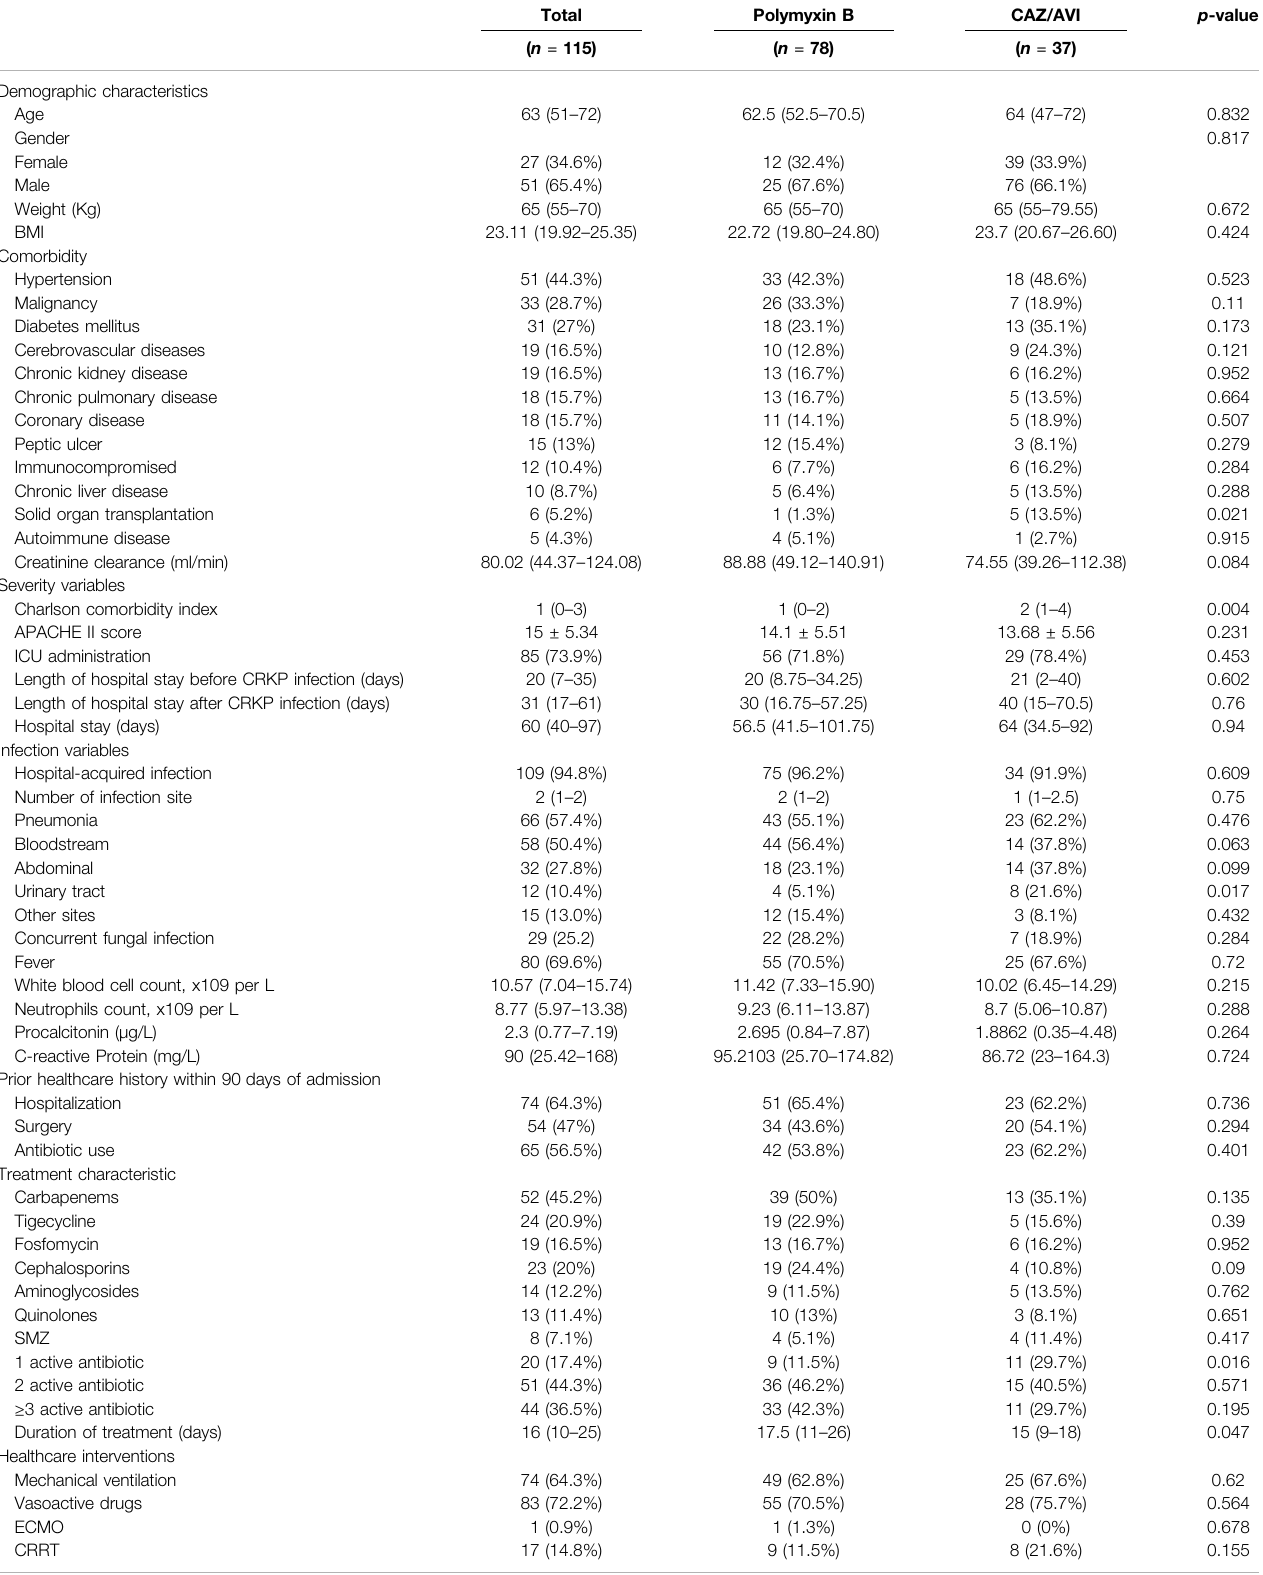
TABLE 2 | Demographic and clinical characteristics of patients with CRKP